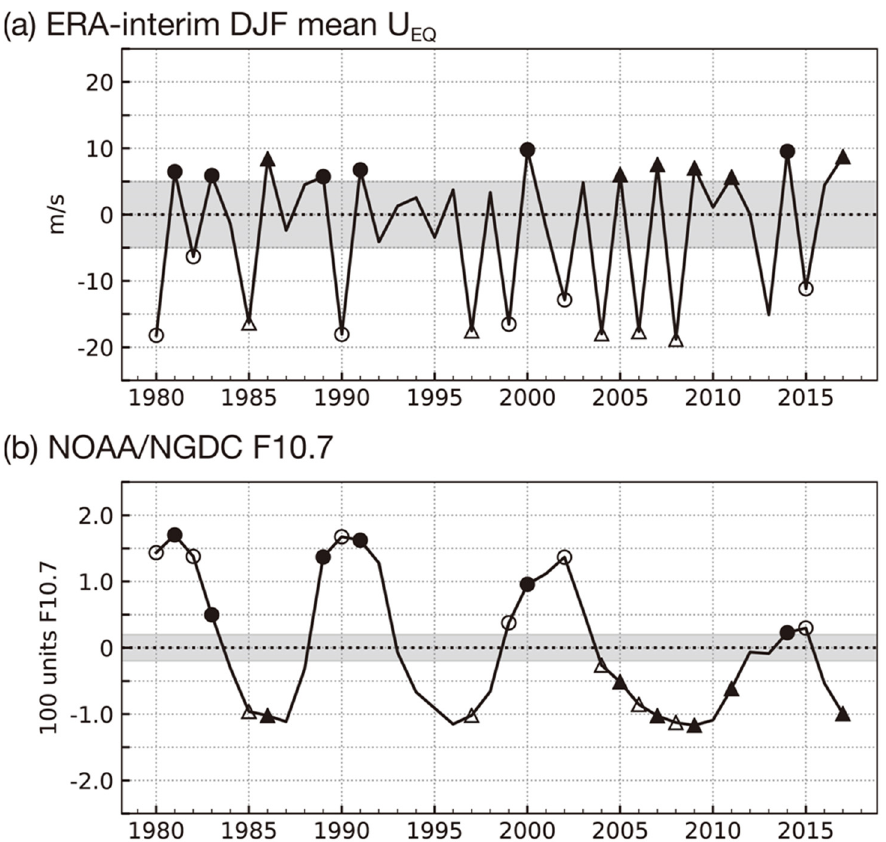
Figure 1. ( a ) Yearly time-series of the DJF mean zonal-mean zonal wind over 10° S–10° N at 50 hPa from ERA-Interim data. Absolute values of the equatorial zonal wind speed less than 5 m/s are gray-shaded; ( b ) Same as ( a ), but for the DJF mean of F10.7 from NOAA/NGDC. F10.7 is smoothed using a Fourier filter of a 2.5-year rectangular window, prior to calculating monthly mean values. Absolute values of F10.7 less than 0.2 are gray-shaded. Closed/open symbols denote QBO-W/QBO-E. Circles/triangles denote S max /S min . The closed triangles denote the QBO-W/S min years, open triangles denote the QBO-E/S min years, and open and closed circles denote the QBO-W/S max and QBO-E/S max years, respectively.